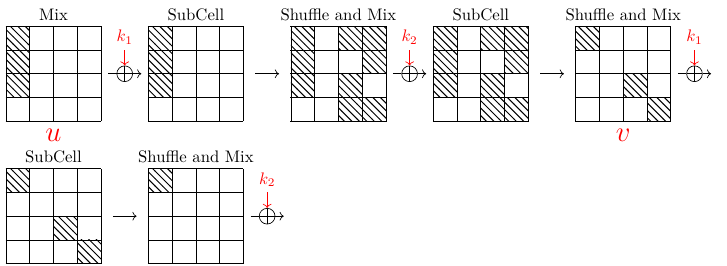
Figure 8: Linear trail with a minimal number of active S-boxes over four rounds of Midori , with only one active column in the input- and output masks. If the randomness of the keys k 1 and k 2 is taken into account, then the trail has correlation